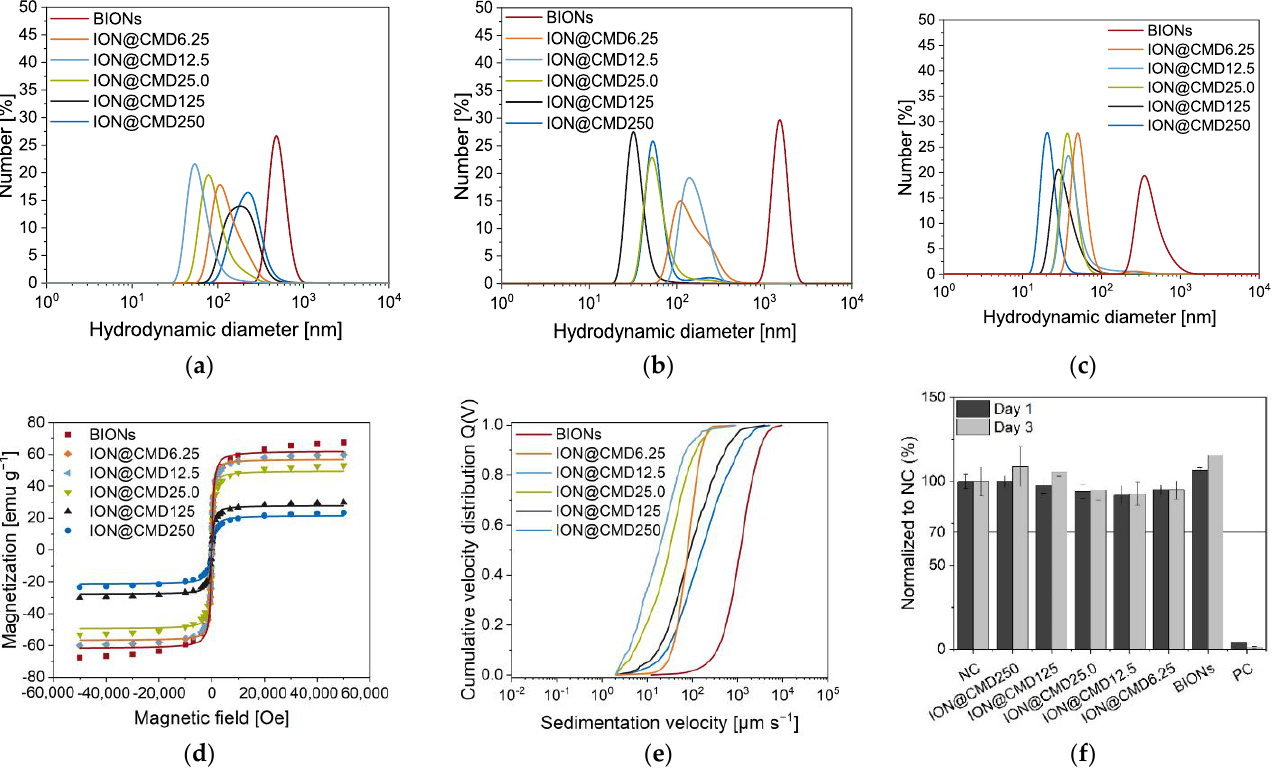
Figure 5. DLS measurements of BIONs and IONs@CMD in ( a ) dH 2 O pH = 7, ( b ) 50 mM PBS (pH = 7.4), and ( c ) human plasma. The equilibration time was set as 120 s. The temperature set for the water and PBS was 25 °C and the human plasma temperature was 37 °C. SQUID analysis at a temperature of 300 K using the LangevinMod fit ( d ), cumulative velocity distribution at room temperature, and ( e ) a pH ~ 7 in water. Cytocompatibility was analyzed by XTT assay with smooth muscle cells ( f ) with a negative control (NC) and a positive control (PC). Results are normalized to NC.